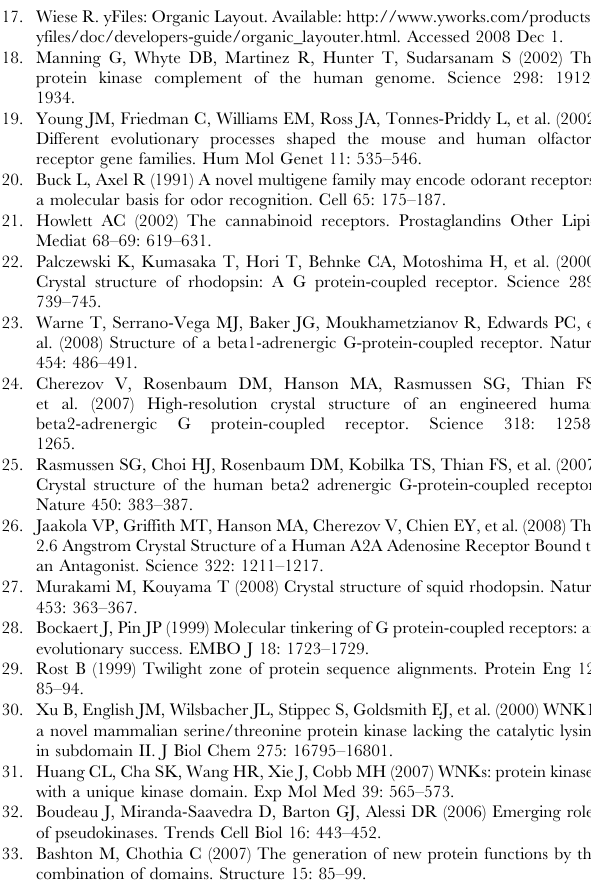
Figure S4 Comparison of trees and networks: STE and WNK kinases